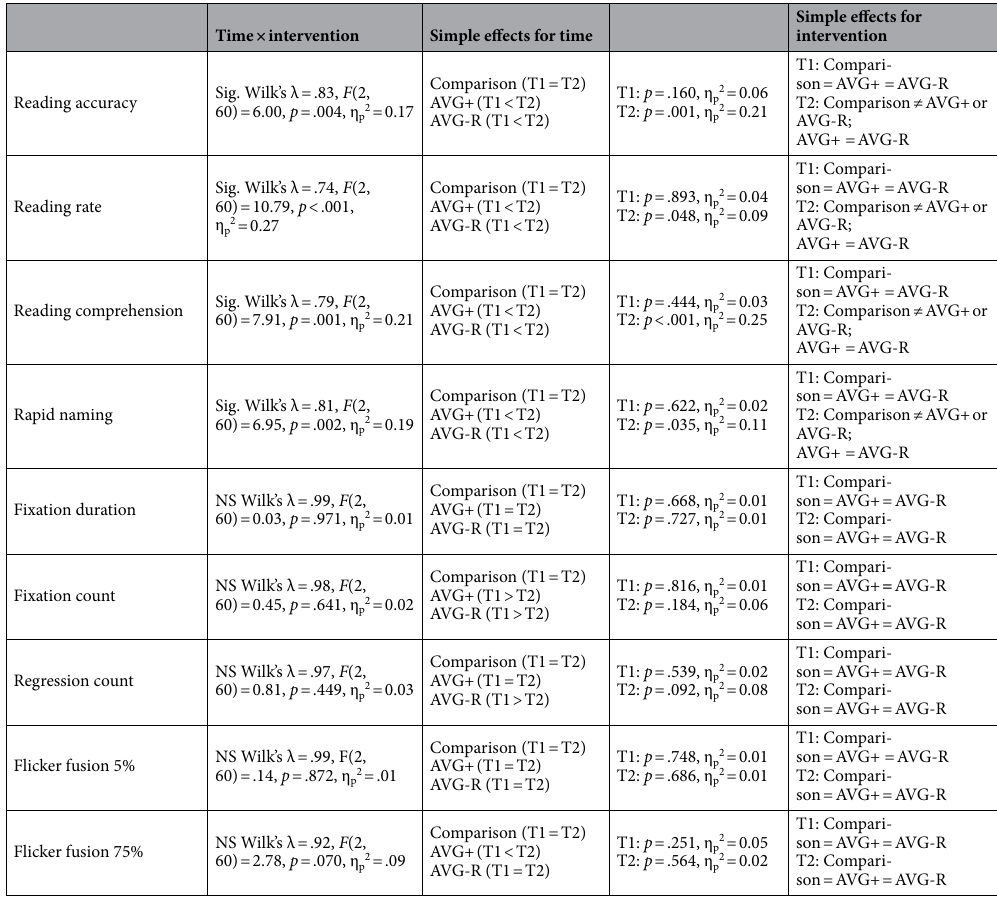
Table 1. Analysis of variance results and summary of post hocs for the effects of intervention on of reading, eye movements and magnocellular tasks. Sig = significant; NS = Non-significant; AVG-R = Action Video Game- Regular Group; AVG + = Increased Attention Action Video Game Group; Comparison = Comparison